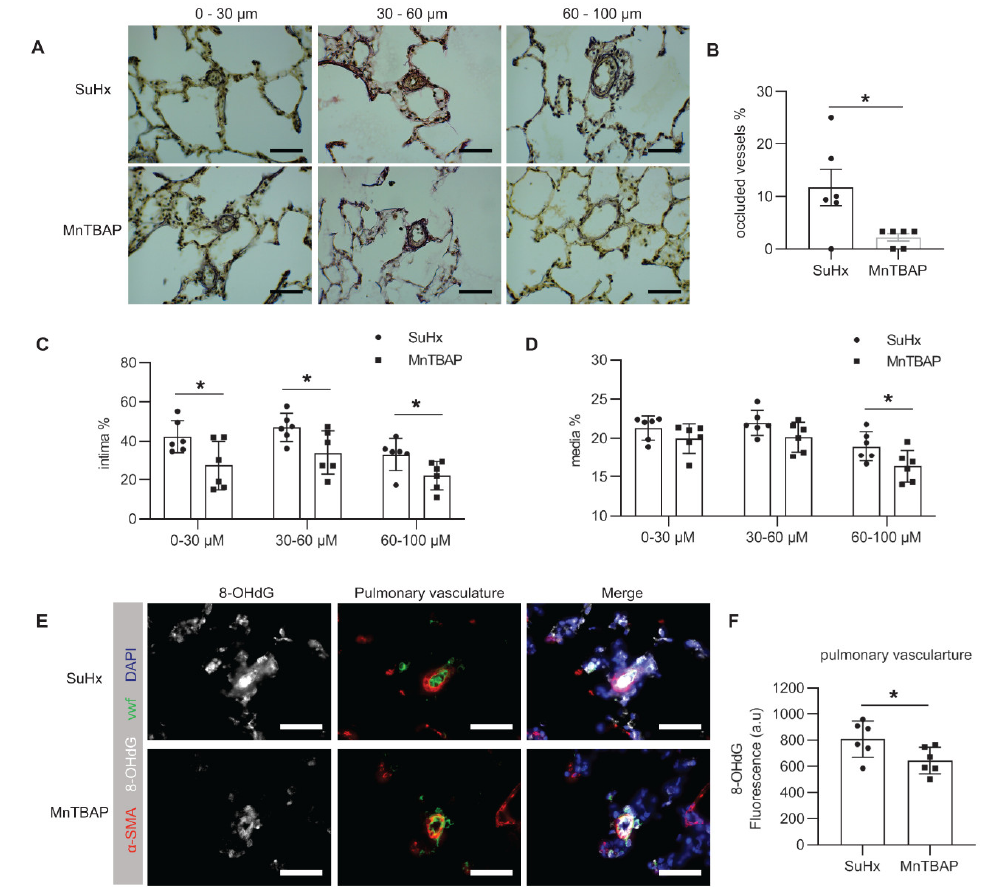
Figure 5. MnTBAP reduces pulmonary vascular remodeling and oxidative damage in SuHx-induced PAH in rats. ( A ) Representative images of the pulmonary vasculatures by Elastica van Giesson staining. Scale bar: 50 µm. ( B ) Quantification of occluded vessels in SuHx and MnTBAP-treated rats. ( C ) Quantification of intima remodeling ratio in pulmonary vasculatures between 0–30, 30–60 and 60–100 µm, respectively. ( D ) Quantification of media remodeling ratio in pulmonary vasculatures between 0–30, 30–60 and 60–100 µm, respectively. ( E ) Representative images of 8-OHdG immunofluorescence staining in the lungs. Scale bar: 50 µm. α-SM (red), vwF (green) and DAPI (blue) were co-stained with 8-OHdG (white). ( F ) Quantification of 8-OHdG intensity shows that MnTBAP reduced 8-OHdG within the pulmonary vasculatures. * p < 0.05. Data presented as mean ± SD. 8-OHdG: 8-Oxo-2′-deoxyguanosine, α-SM: alpha smooth muscle actin, vwF: von Willebrand factor.